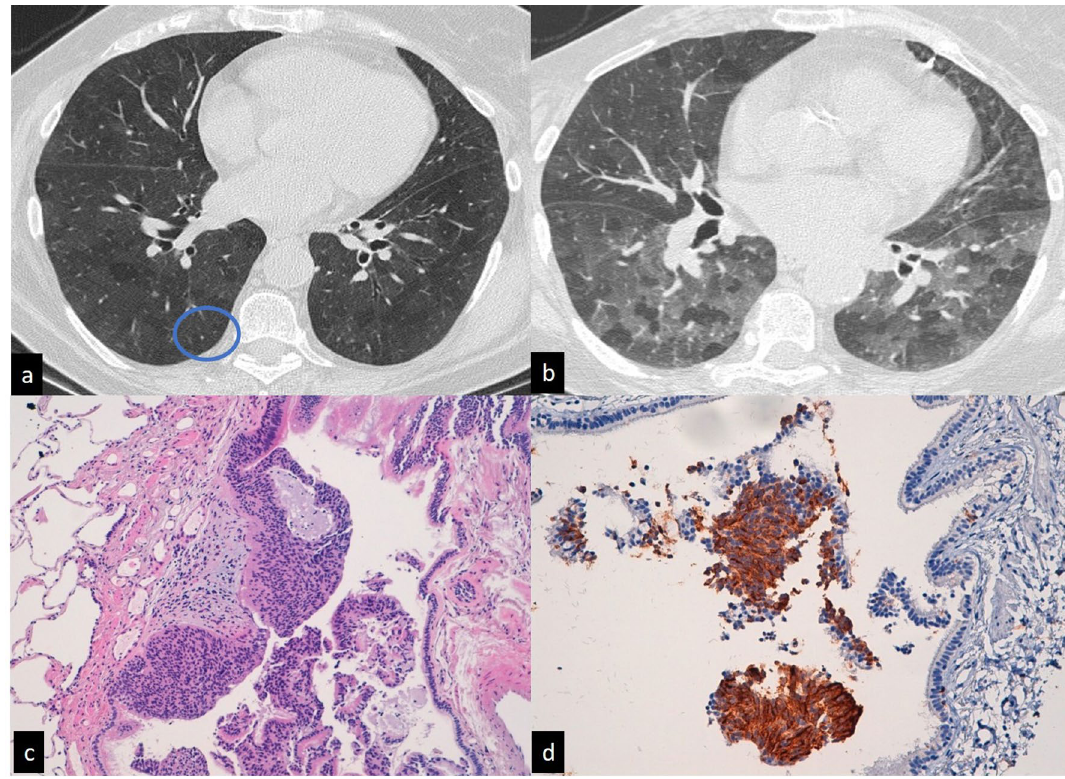
Figure 2. Diffuse idiopathic pulmonary neuroendocrine hyperplasia (DIPENCH). CT scan ( a , b ) shows diffuse mosaic attenuation in both hemithoraces. A tiny nodule ( a , circle) is also present in the right lower lobe. In